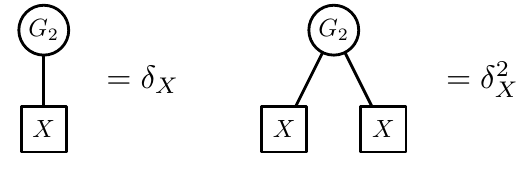
Figure 22: The decorated constraints forcing the structure of the tiles involving the part G 2 . The constraints should hold for every X ∈ P